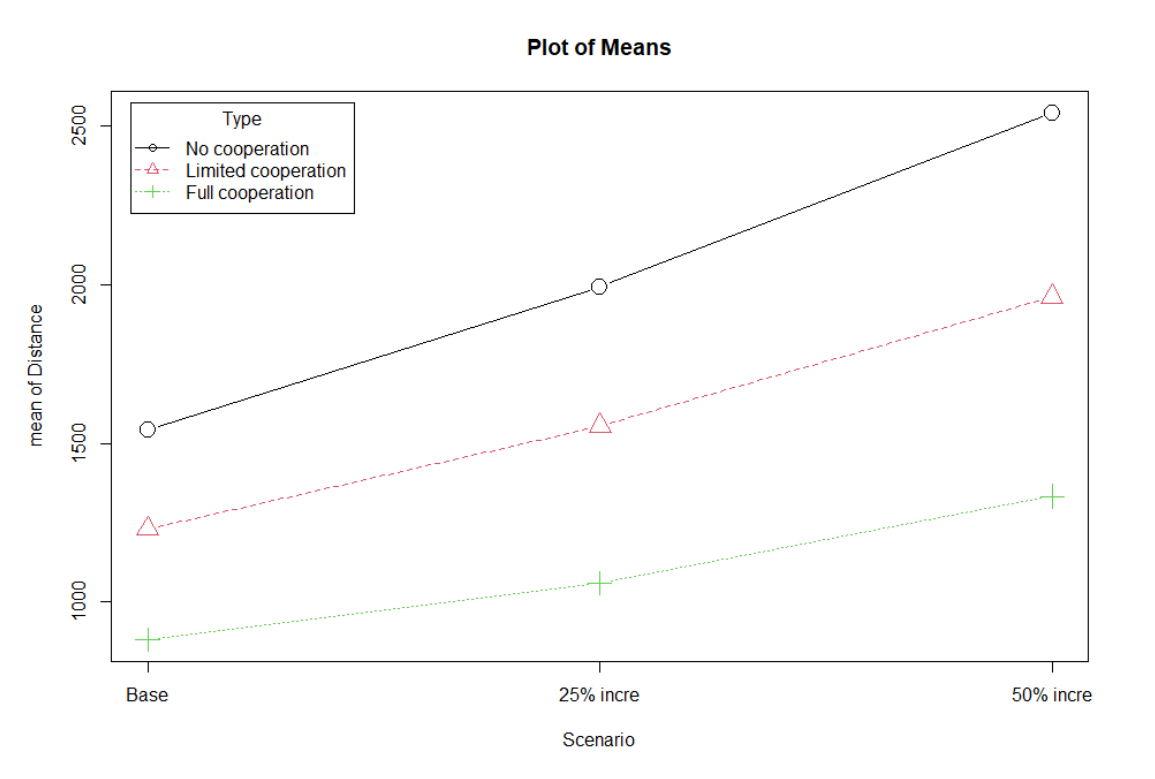
Figure 11. Mean plots by demand scenario and cooperative setting for total distances.